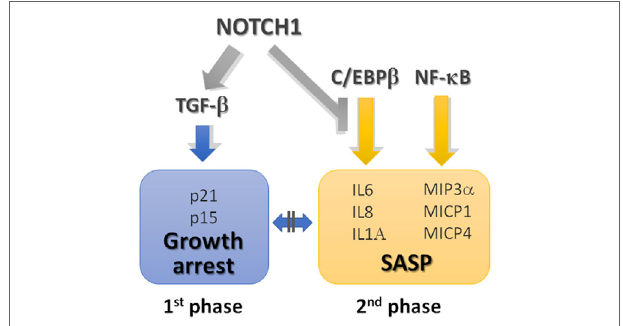
FiGURe 6 | Notch signaling regulates cancer cell senescence and the associated secretome profile. Notch activity is dynamically regulated during the acquisition of the full cell senescence. Through an elegant work on cancer models of oncogene-induced senescence (OIS), Notch-induced senescence (NIS), and DNA damage senescence induced in human diploid fibroblasts, and confirmed in in vitro models of pancreatic and liver cancer, Hoare et al. demonstrated that the first phase of senescence is characterized by the activation of Notch with the consequent promotion of transforming growth factor- β (TGF- β ) expression and the inhibition of transcriptional activity of C/EBP β transcriptional activity. This is unleashed with Notch downregulation during full senescence acquisition resulting in the expression of pro-inflammatory senescence-associated secretory profile (SASP) (256). See text for